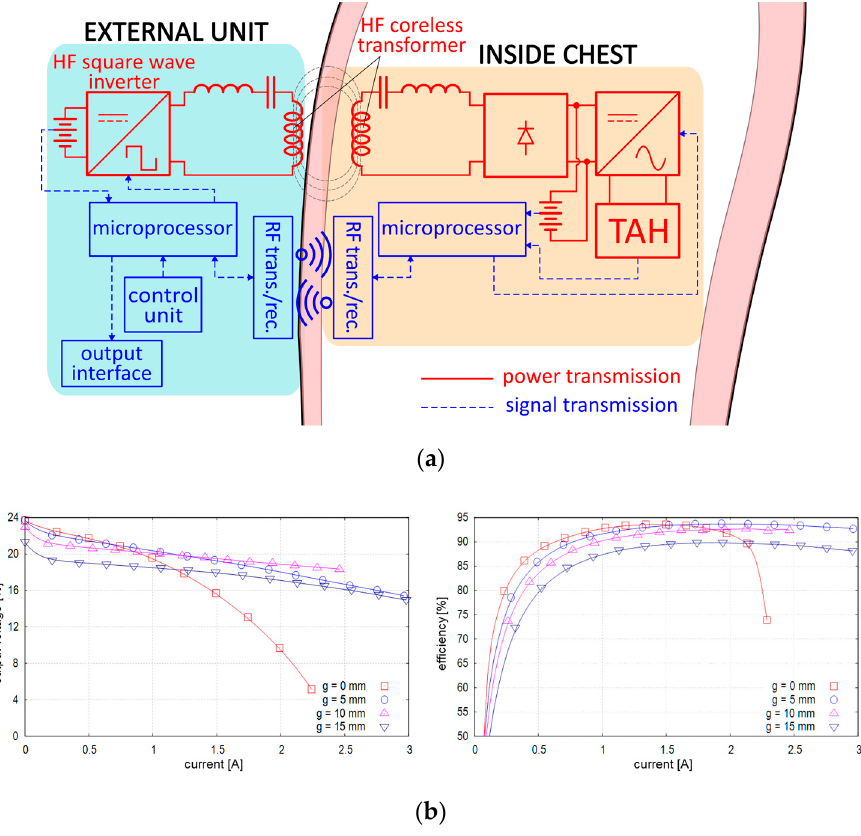
Figure 6. Layout and performances of a TET system; ( a ) scheme of the power and information circuits [59]; and ( b ) rectifier output voltage and efficiency for different air-gap values.